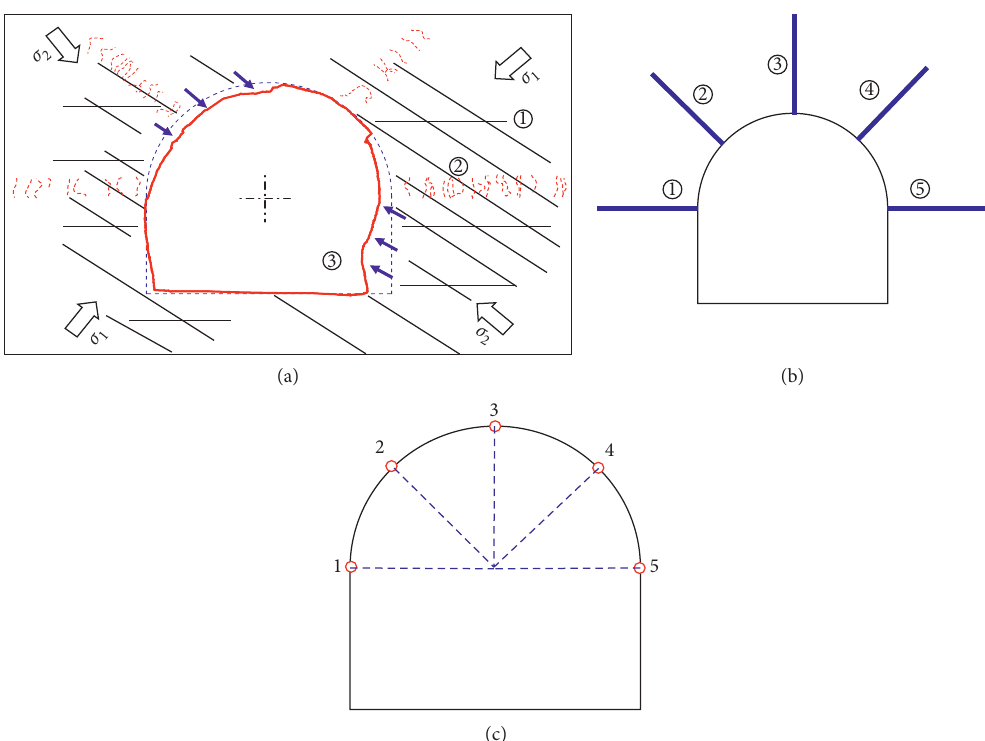
Figure 3: Basic principle of large deformation measurement in the tunnel. (a) Major aspects of large deformation, (b) boreholes to measure information in the surrounding rock, and (c) monitoring points on the tunnel